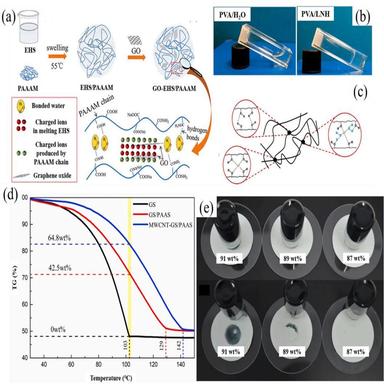
(a) The synthesis process of EHS/PAAAM and GO-EHS/PAAAM as well as mechanisms of the PAAAM and graphene oxide tailoring phase change behaviors of EHS, Reproduced with the permission of Royal Society of Chemistry. (b) pictures of 15 wt% PVA solutions in H2O and LNH , (c) schematic illustration of gelation in PVA/LNH system including PVA intermolecular association via hydrogen bonding between –OH groups, Reproduced with the permission of Royal Society of Chemistry. (d)